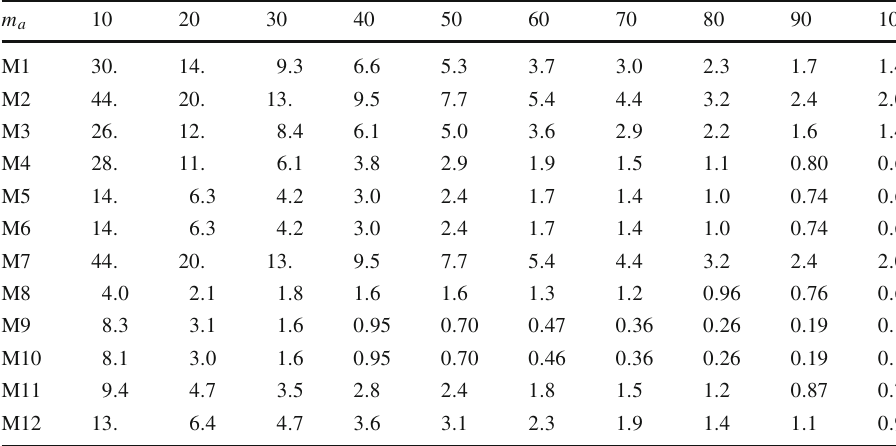
Table 2 The values of σ × BR ττ × (cid:15) in fb for prod . f a = 1 TeV for each of the models defined in Table 1. The main backgrounds are di-top and single-top (59.2 fb), Z /γ ∗ (24.7 fb), and di-bosons (11.0